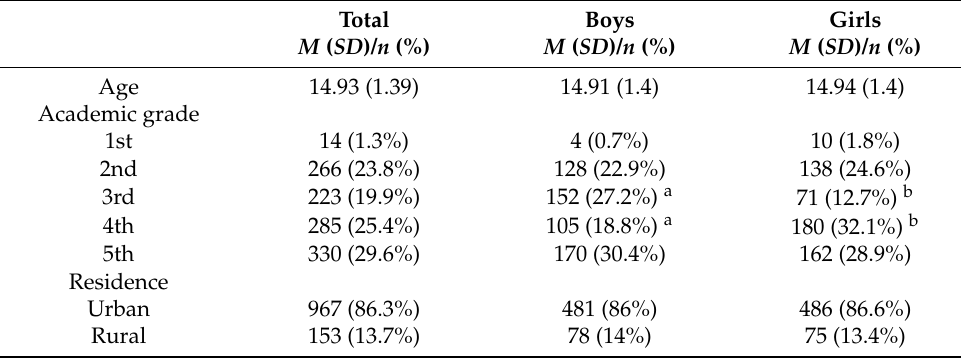
Table 1. Sociodemographic characteristics of the sample.